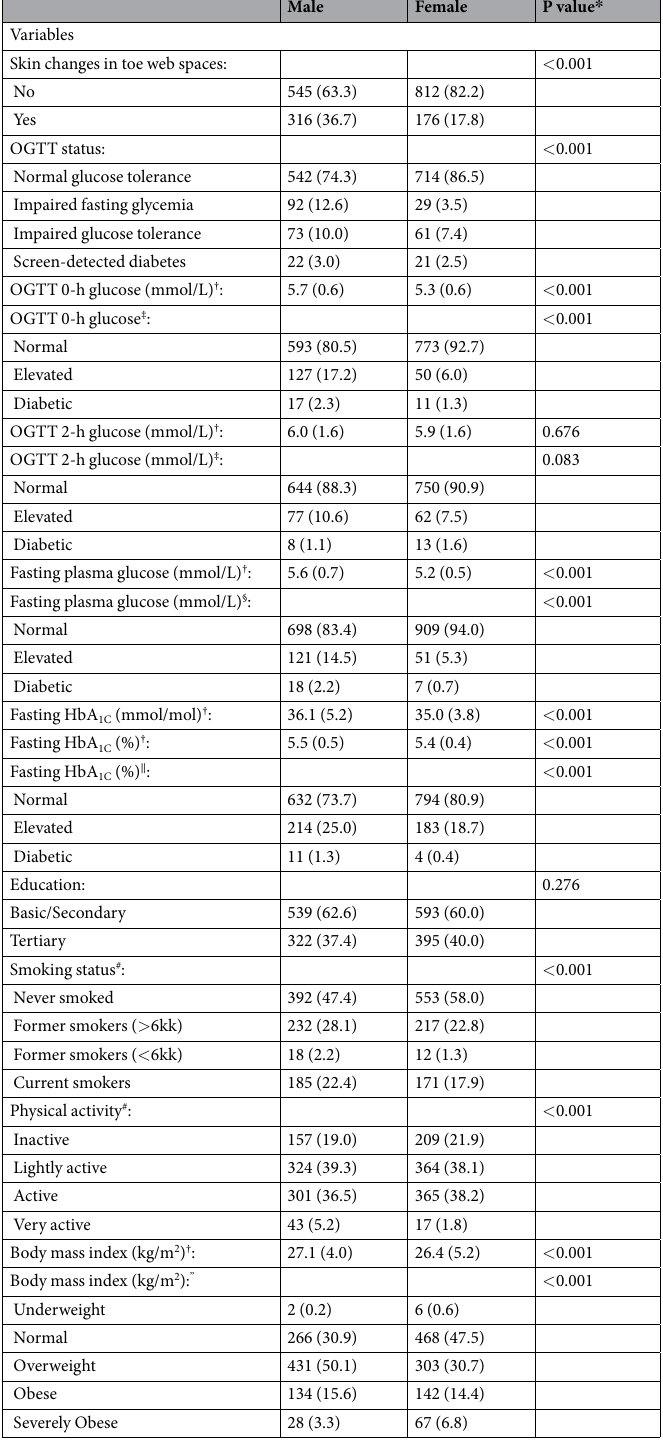
Table 1. The characteristics of the cohort study population concerning skin findings in toe web spaces, glucose metabolism and confounding factors according to sex. Values are numbers (percentages) of subjects unless stated otherwise. * The Mann-Whitney U-test was used when testing continuous variables and Chi-Square test or Fisher exact test for categorical variables. † Values are mean (standard deviation, SD). ‡ OGTT: 1,571 study cases first attended and 1,554 of them completed OGTT. OGTT was not conducted if FPG was < 8.0 mmol/l just before the test (n = 11). OGTT 0-h or OGTT 2-h was not eligible in six (n = 6) study cases. N = 278 did not attend the OGTT. § Data of FPG was missing from n = 45. § Data of HbA1c was missing from n = 11. # Data of smoking status and physical activity was missing from n = 69 (The reason was missing data was that all study cases did not fill health questionnaires). ” Data of body mass index was missing from n = 2 (The reason for missing data was that all study cases did not come to the